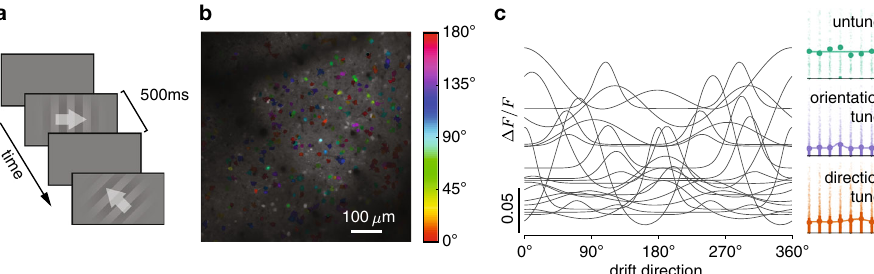
Fig. 2 Experimental design, population recordings, and neural tuning. a Mice passively observed sequences of drifting gratings (white arrows overlaid for illustration only), interleaved with blank screens. b Example fi eld-of-view with signi fi cantly tuned neurons color coded by their preferred orientation tuning. c Left: example fi tted tuning curves of 20 signi fi cantly tuned neurons. Right: example tuning curves (dots + bars: raw tuning, mean ± 25 – 75% percentiles; line: fi tted) fi tted to per-trial neural responses (dots, horizontally jittered) for an untuned (top), orientation-tuned (middle) and direction-tuned (bottom)